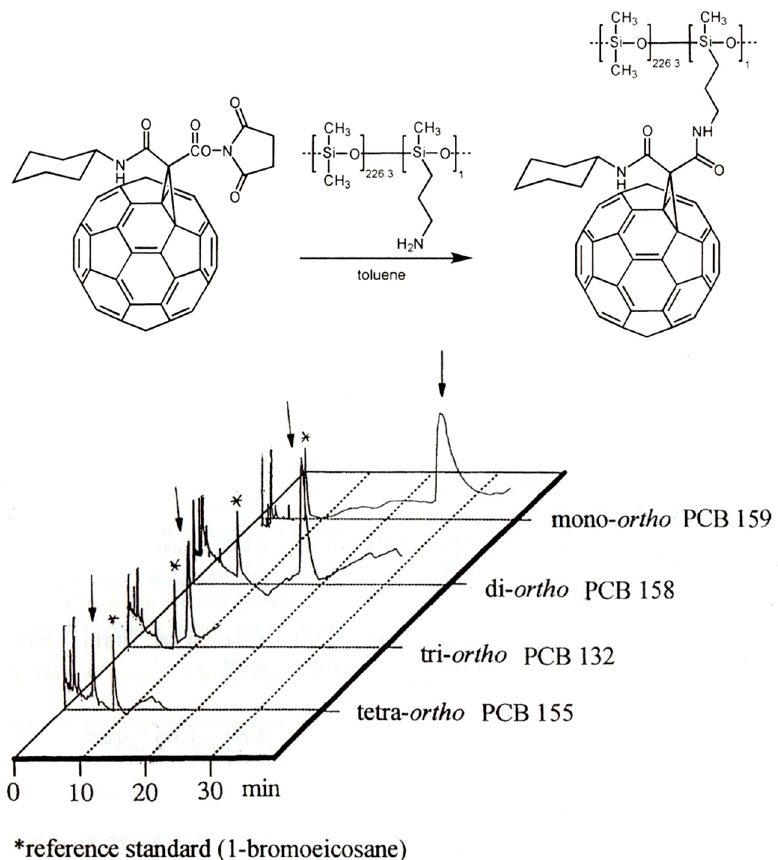
Figure 22. Top : Synthesis of C 60 linked to aminopropyl poly(dimethylsiloxane). Bottom : Gas chromatographic elution order of hexachlorobiphenyl congeners with different degree of ortho -chloro substitution. The increased retention time of the second eluted enantiomer is marked with an arrow. 10 m × 0.25 mm I.D. fused silica column coated with the C 60 phase (0.25 μ m), 190 °C, carrier: 0.6 bar (at gauge) helium, electron capture detection. Reprinted with permission from [93].